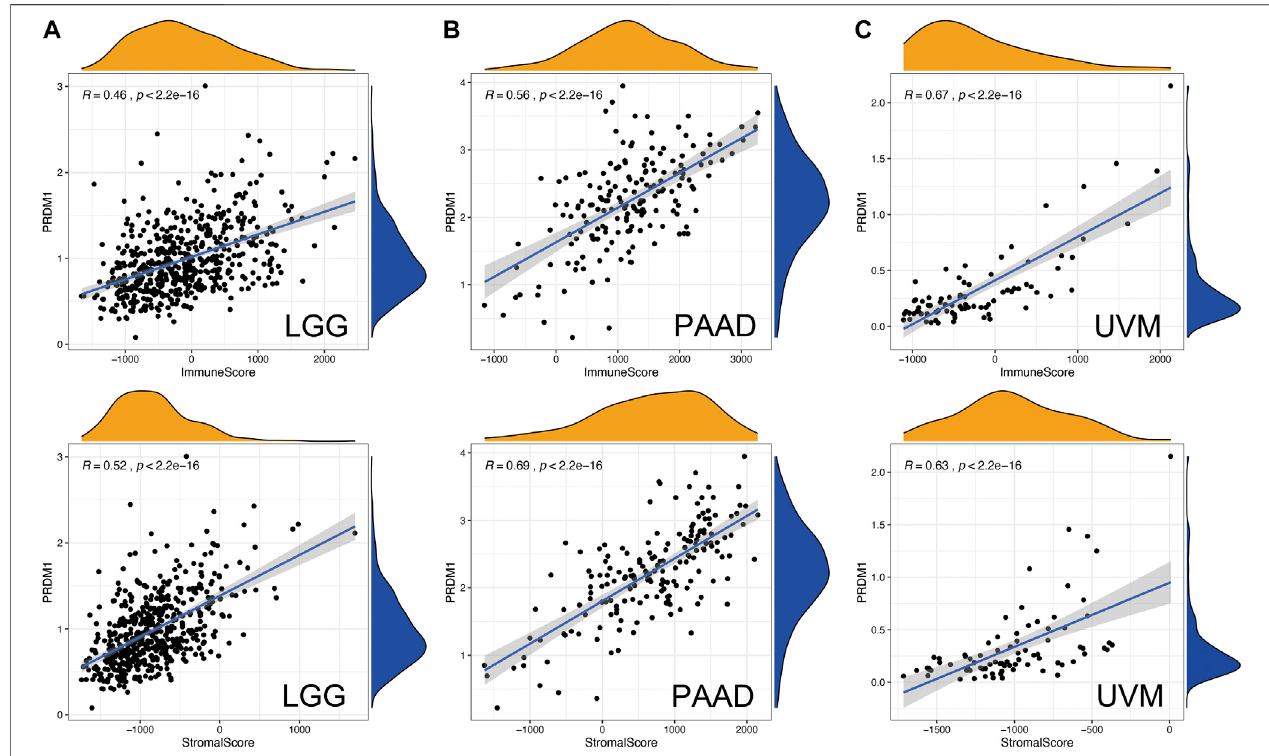
FIGURE 4 | Correlation of PRDM1 expression with Estimate Score in in low grade glioma (LGG), pancreatic adenocarcinoma (PAAD) and uveal melanoma (UVM).